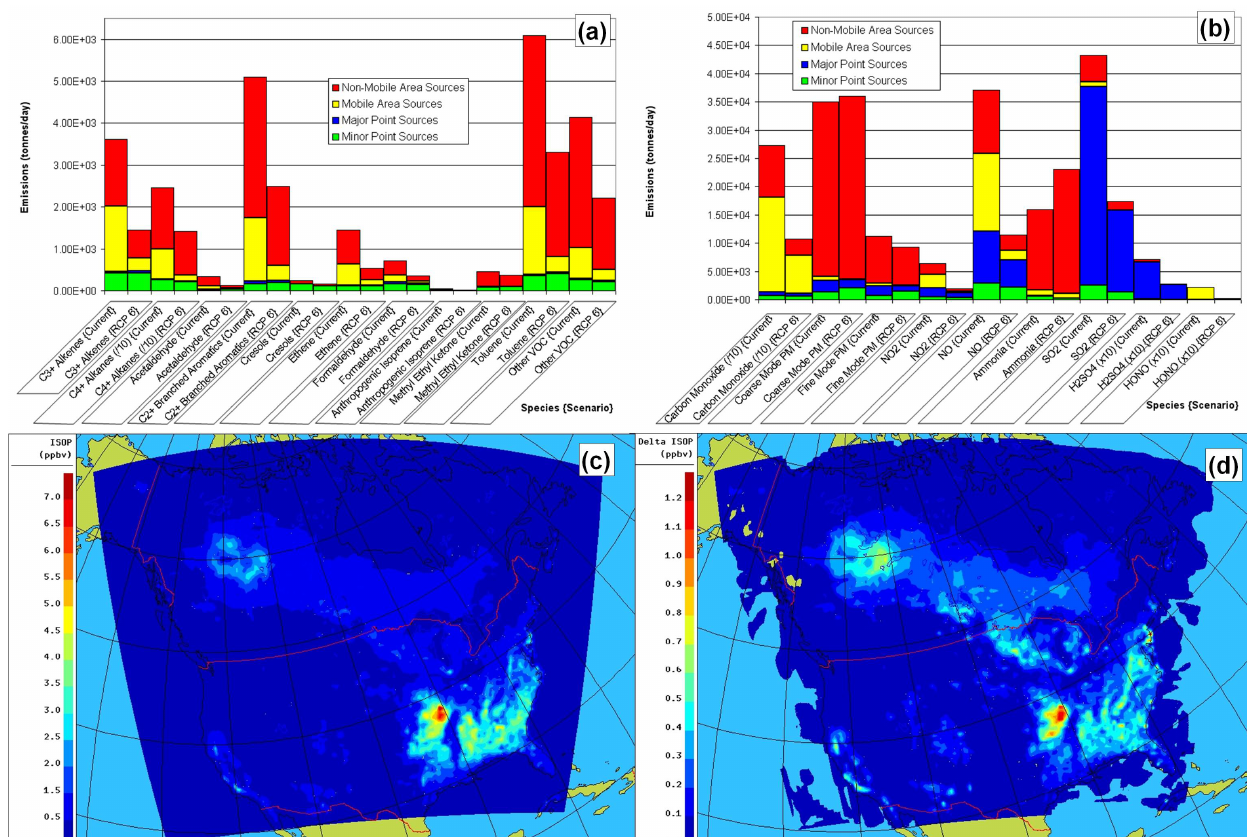
Fig. 2. Comparison of current and RCP 6 emissions for (a) the suite of emitted anthropogenic VOCs in the model mechanism, and (b) other emitted species. Note that some species’ emitted mass has been scaled to allow plotting on the same vertical axis. “/10” in the species’ name means the emitted mass has been reduced by a factor of ten, “ × 10” means the emitted mass has been increased by a factor of 10. Changes associated with biogenic emissions can be seen in through comparing the average summer isoprene concentration under current climate conditions (c) , to the change in average summer isoprene in the future climate (d)